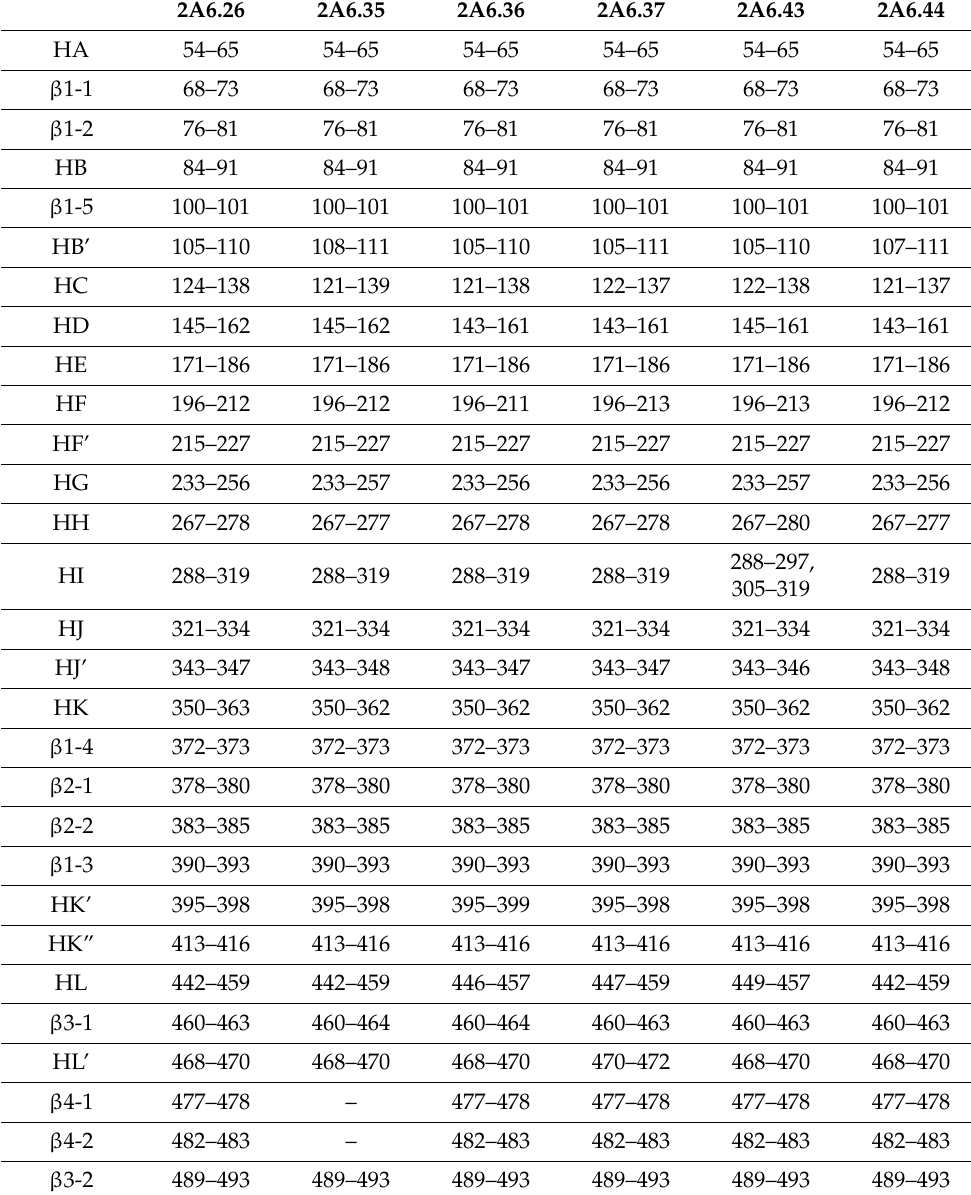
Table 3. Secondary structure formation in >50% of trajectories for last 100 ns of simulations of